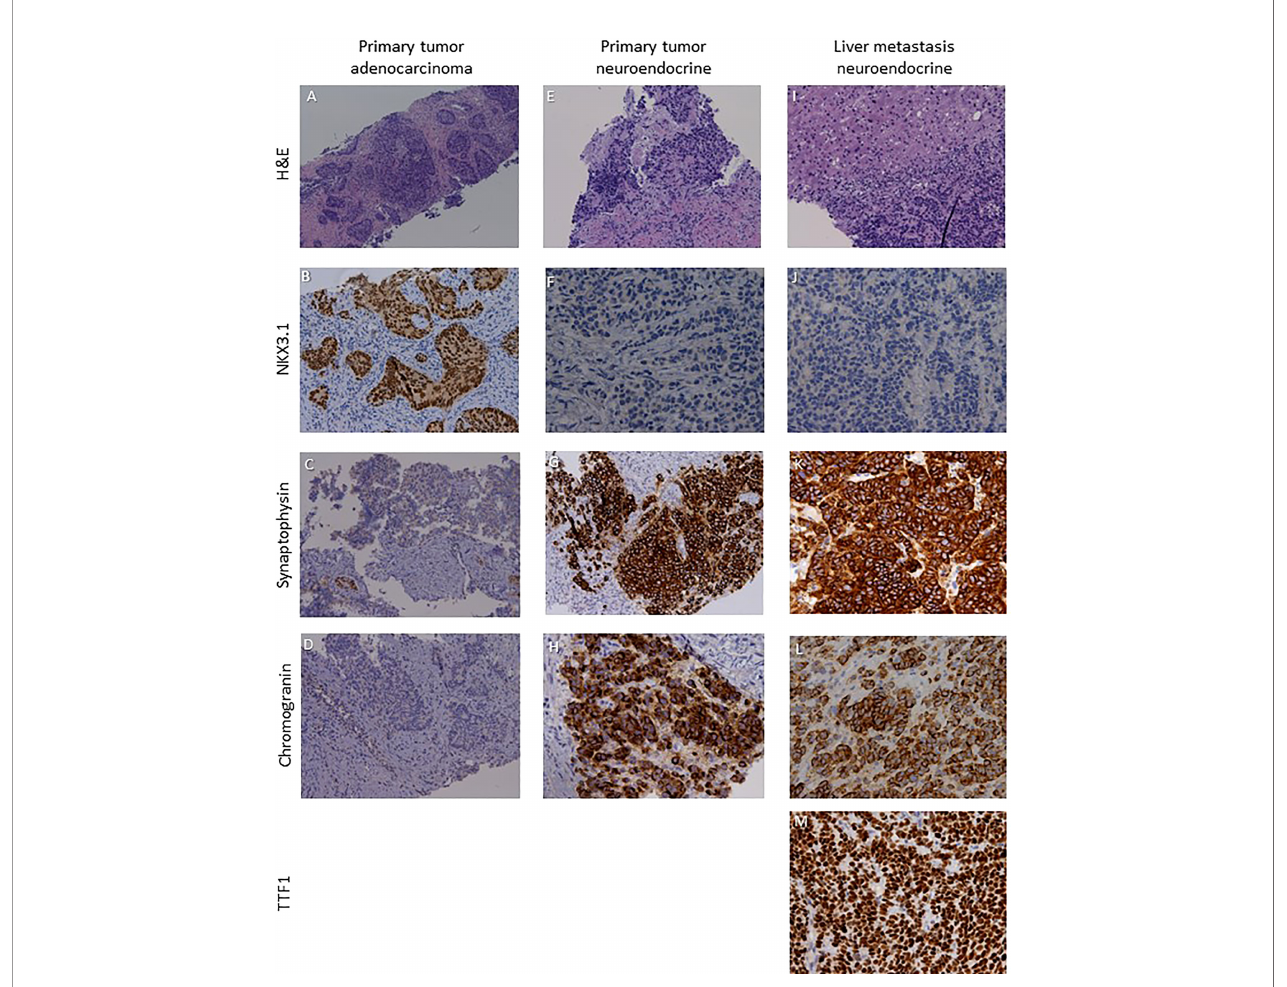
FIGURE 3 | Sections are from patient 2 prostate and liver biopsies and stained as labelled. Primary tumor was a NKX3.1+ synaptophysin- chromogranin-·prostate adenocarcinoma (A – D) with foci of NKX3.1- synaptophysin+ chromogranin+ high grade neuroendocrine cardnoma (E – H) . Liver metastases were characterized by a NKX3.1- synaptophysin+chromogranin+TTFl+ small cell neuroendocrine phenotype (I – M) . Original magni fi cations: 4X (A) , 10X (B – D, G, I) , 20X (E, F, H, J – M) . H&N, hematoxylin and eosin; TTF1, thyroid transcription factor